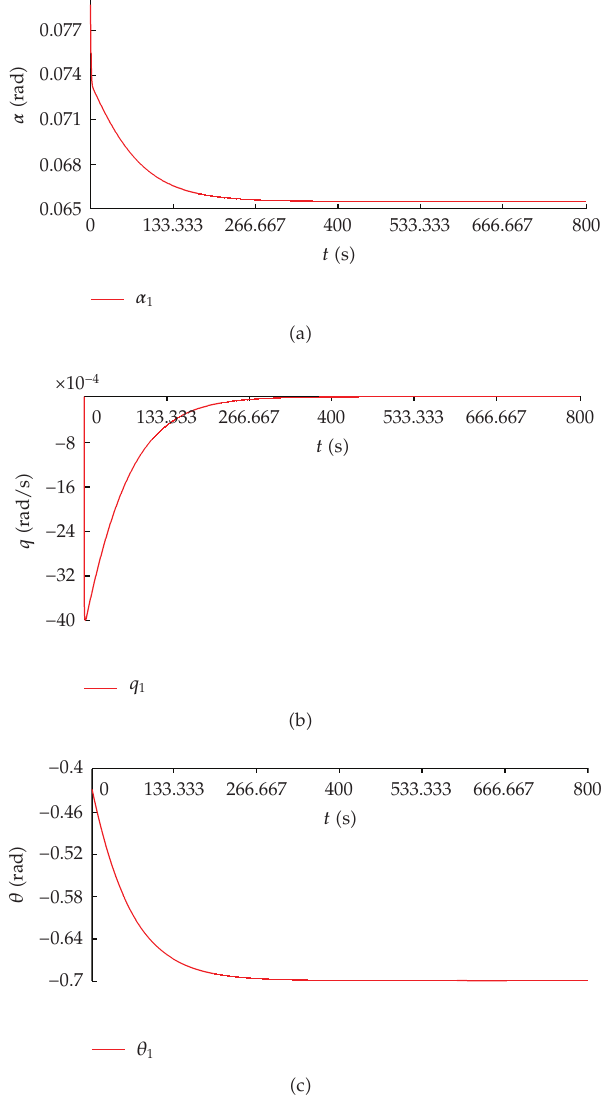
Figure 9: A transfer between two equilibriums, which belong to P 1 (cid:3) simulated in the general model (cid:4) : (cid:7) − 0 . 03866 (cid:5) rad (cid:6) (cid:7) 2 . 216 ◦ → δ (cid:6)(cid:6) δ (cid:6) e (cid:7) − 0 . 428832 (cid:5) rad (cid:6) (cid:7) 24 . 582 ◦ → α (cid:6)(cid:6) θ (cid:6) 1 − 40 . 016 ◦